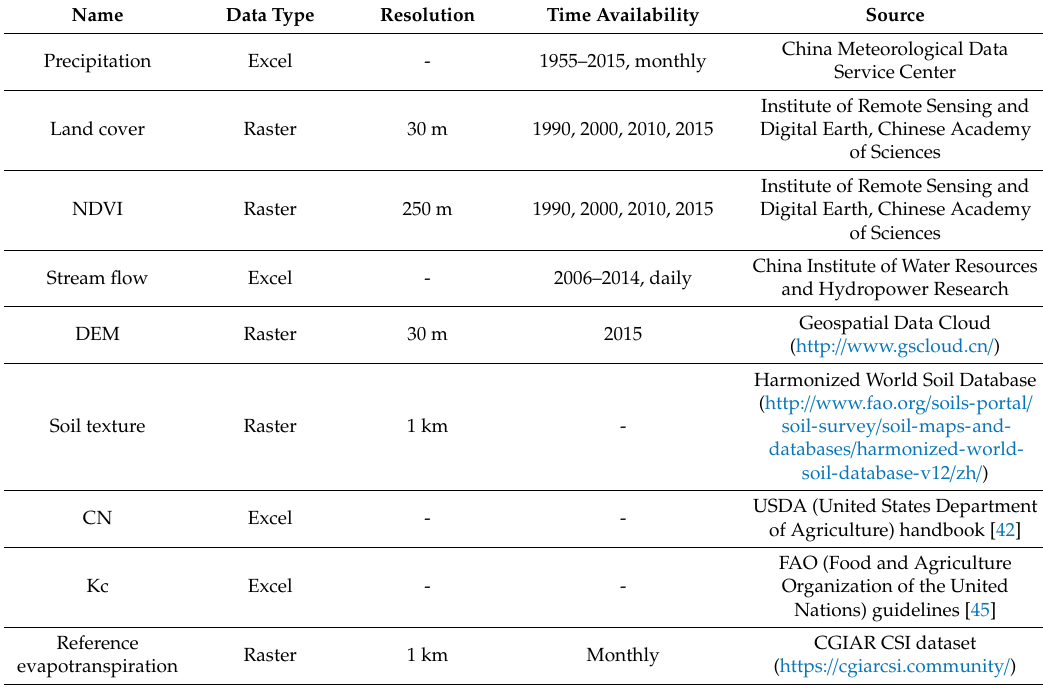
Table 2. Data information and sources.